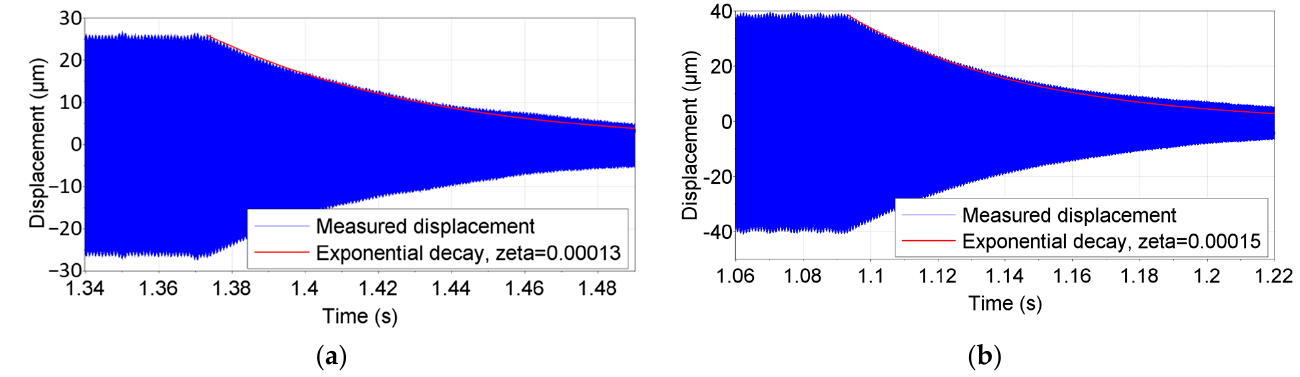
Figure 13. 51CrV4 steel, UHCF specimen, exponential decay: ( a ) Maximum stress = 400 MPa; ( b ) Maximum stress = 600 MPa.